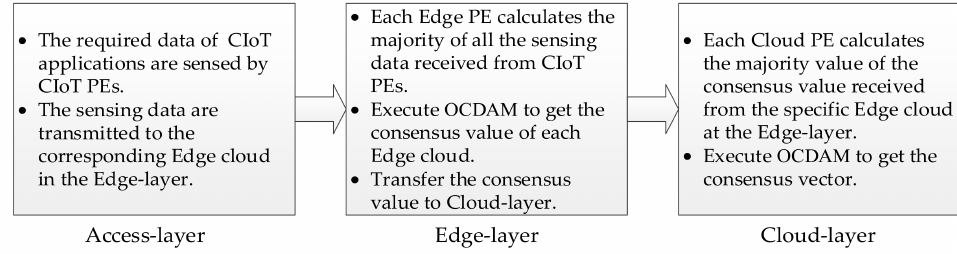
Figure 5. The execution steps of the proposed method.